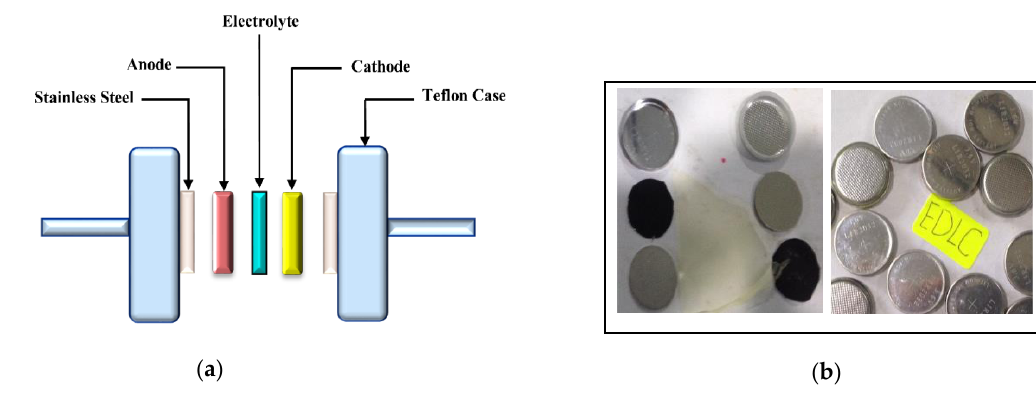
Figure 2. ( a ) Schematic illustration of the setup for CV and EDLC measurements. ( b ) Real images of